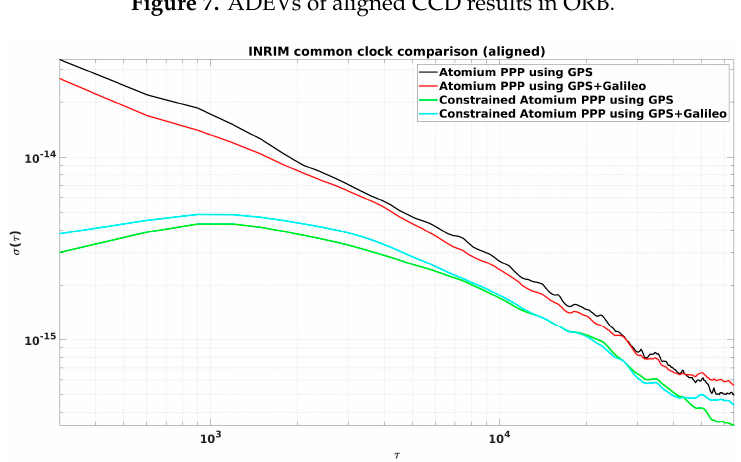
Figure 8. ADEVs of aligned CCD results in INRIM.